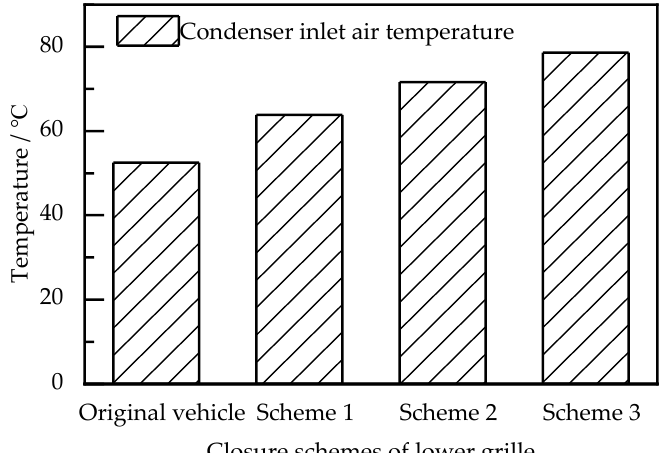
Figure 27. Comparisons of condenser inlet temperature under different lower grille schemes.